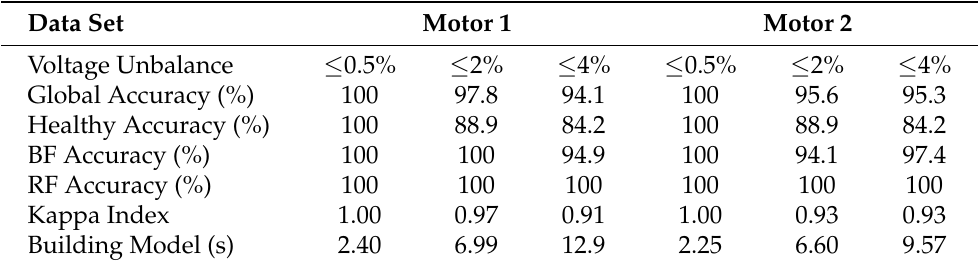
Table 3. Experimental results using the 150 SMI attributes between i a and i b —Multi-fault identification.